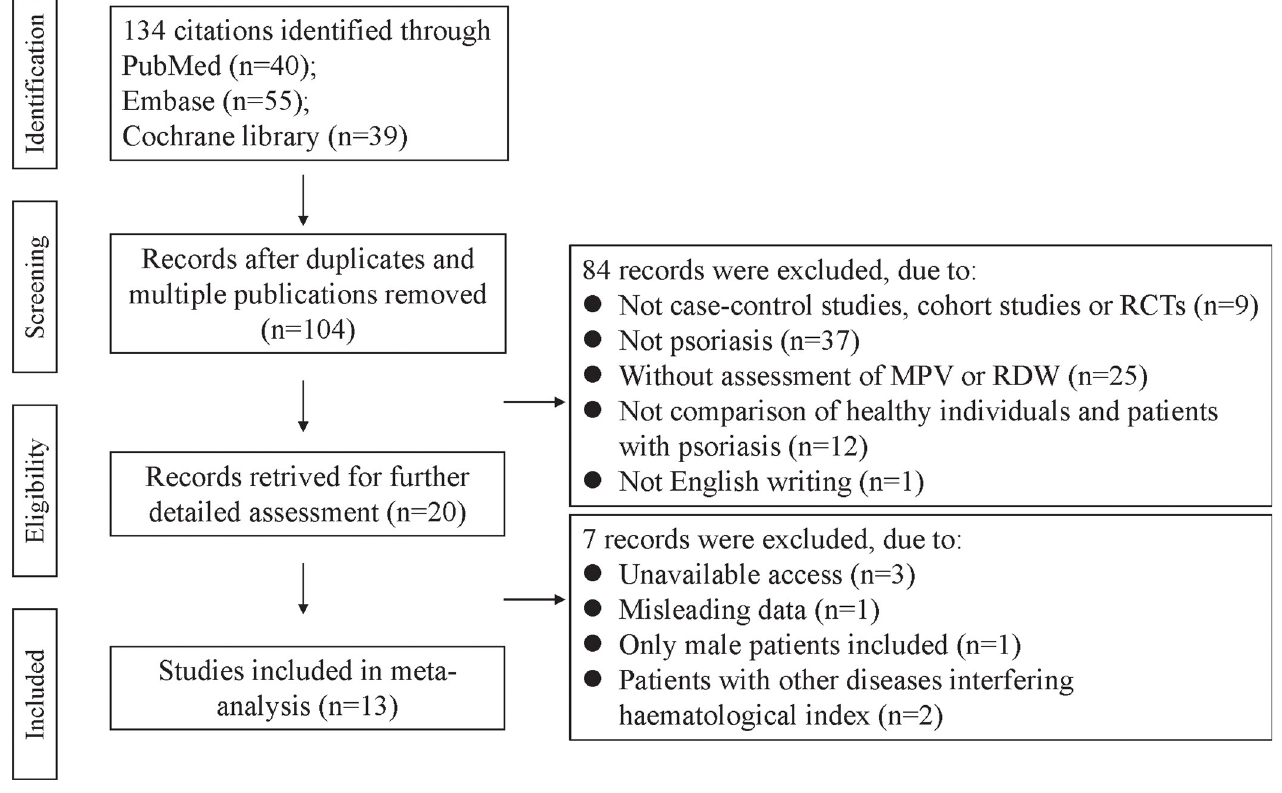
PLOS ONE | https://doi.org/10.1371/journal.pone.0264504 February 25,